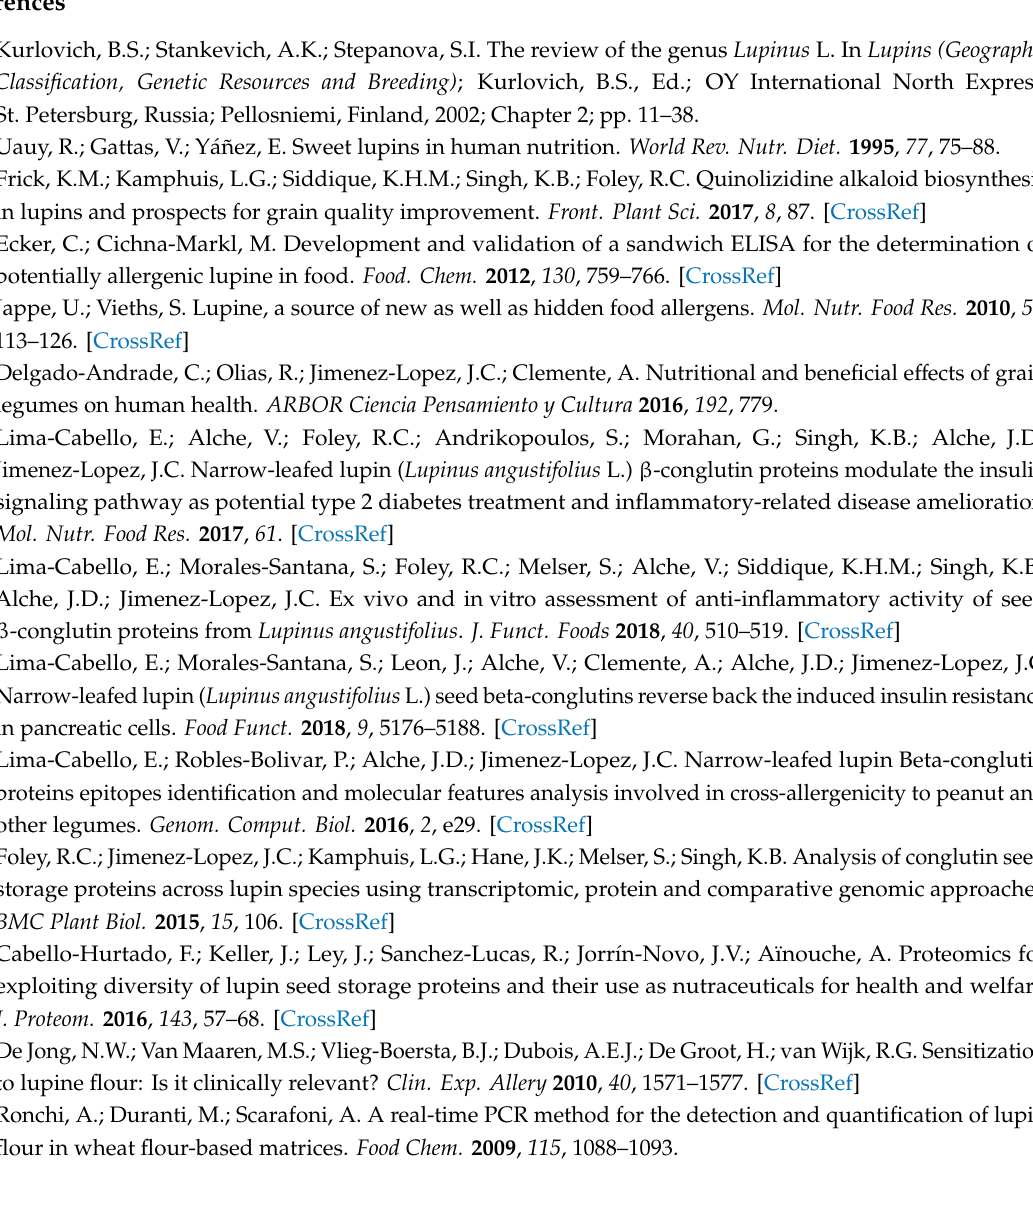
Figure S1: Multiple alignment of the deduced amino acid sequences of β 1 to β 7., Figure S2: Antigenicity assessment of conglutin β 1., Figure S3: Standard curve made of the conglutin β 1